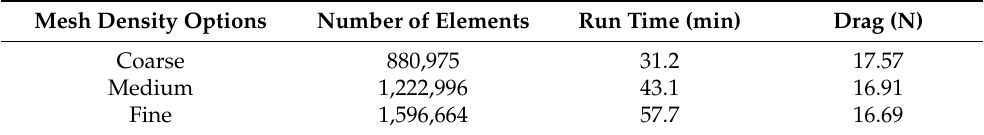
Table 2. Grid independence study of the underwater